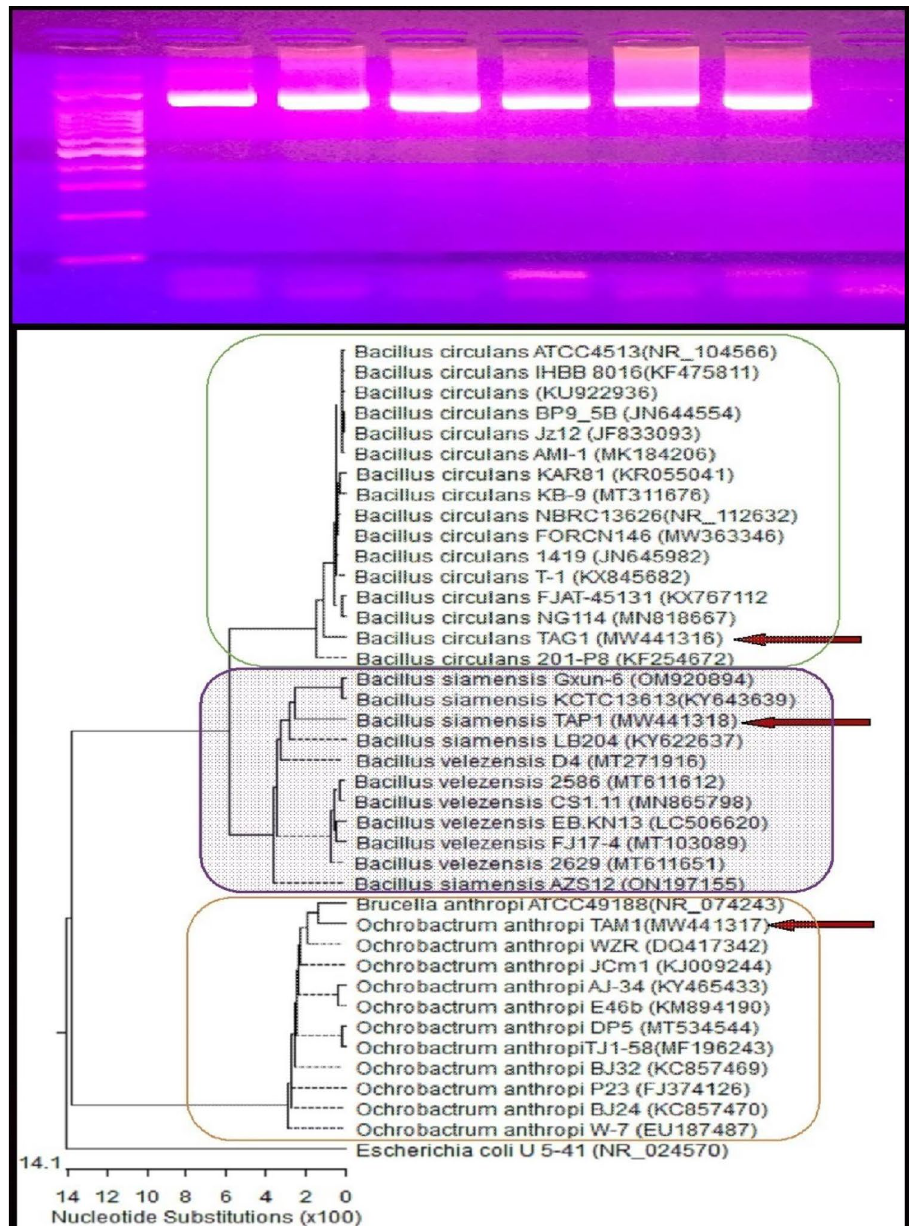
Figure 8. The amplified product as a single compact band of expected size under UV light, and phylogenetic tree based on 16S sequences of rDNA of the bacterial strains isolated in the present study ( Bacillus circulans TAG1, Bacillus siamensis TAP1, and Ochrobactrum anthropi TAM1, arrowed) aligned with closely related sequences accessed from the GenBank. Escherichia coli is included in the tree as an outgroup